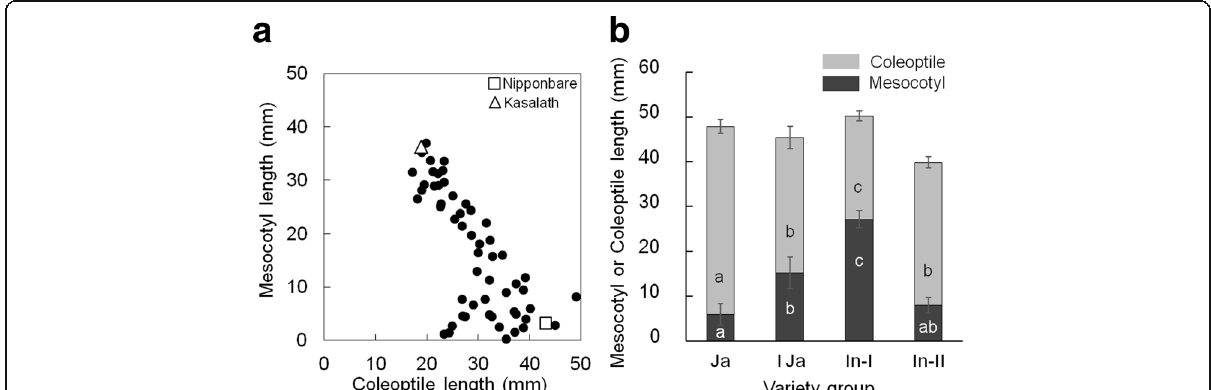
Fig. 2 Mesocotyl and coleoptile length for 57 accessions of RDRS ( a ), Comparison of mesocotyl and coleoptile length in 4 rice variety groups ( b ) Japonica (Ja), Tropical Japonica (TJa), Indica-I (In-I), and Indica-II (In-II); Seeds were sown at 5 cm soil depth and incubated at alternate temperatures of 30 °C and 26 ° C (14 h/10 h). At 14 days after sowing, the seedling were excavated and length were measured. b Means with different letters in the same row indicate significant differences according to the Duncan multiple range test ( P < 0.001). Bars represent mean of length with SE